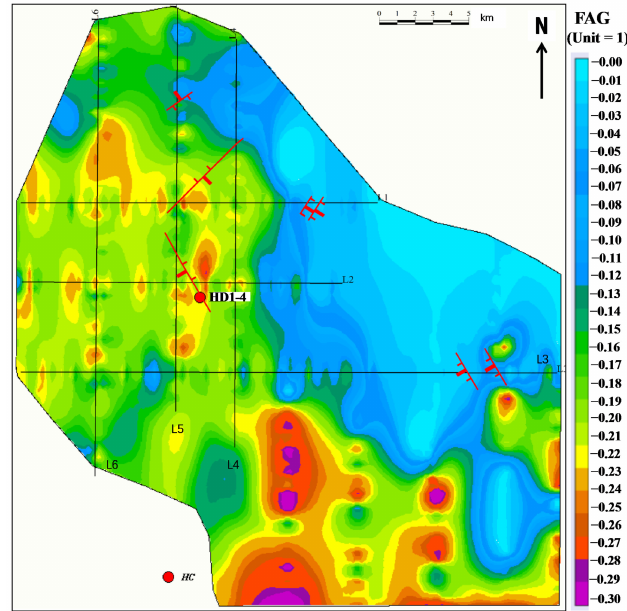
Figure 7. Deep karst prediction distribution map of seismic wave frequency attenuation gradient (FAG) technology in Huanjiang sag (including fault interpretation). The large attenuation gradient indicates the fractures and caves, which are represented by red color in the map. Note: The plane locations of Figure 7 are shown in Figure 1B. HC = Hechi